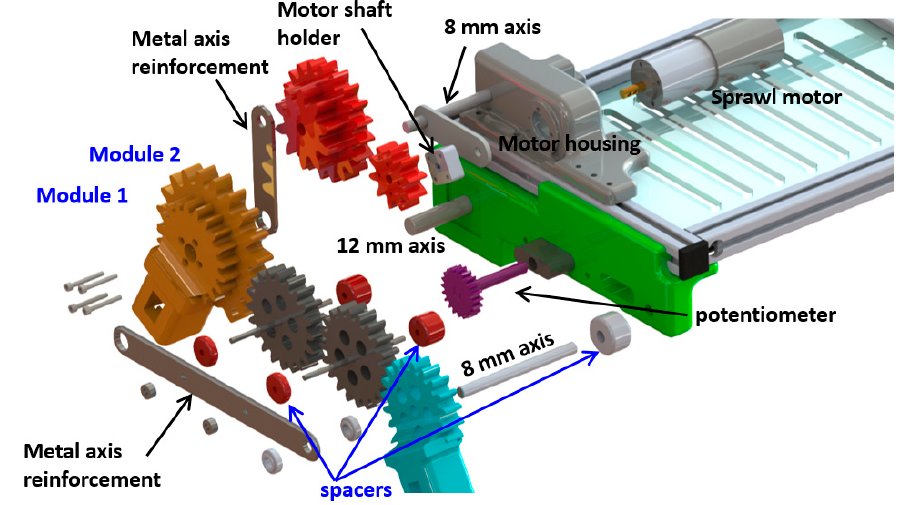
Figure A1 . The detailed design of RSTAR’s sprawl. Figure A1. The detailed design of RSTAR’s